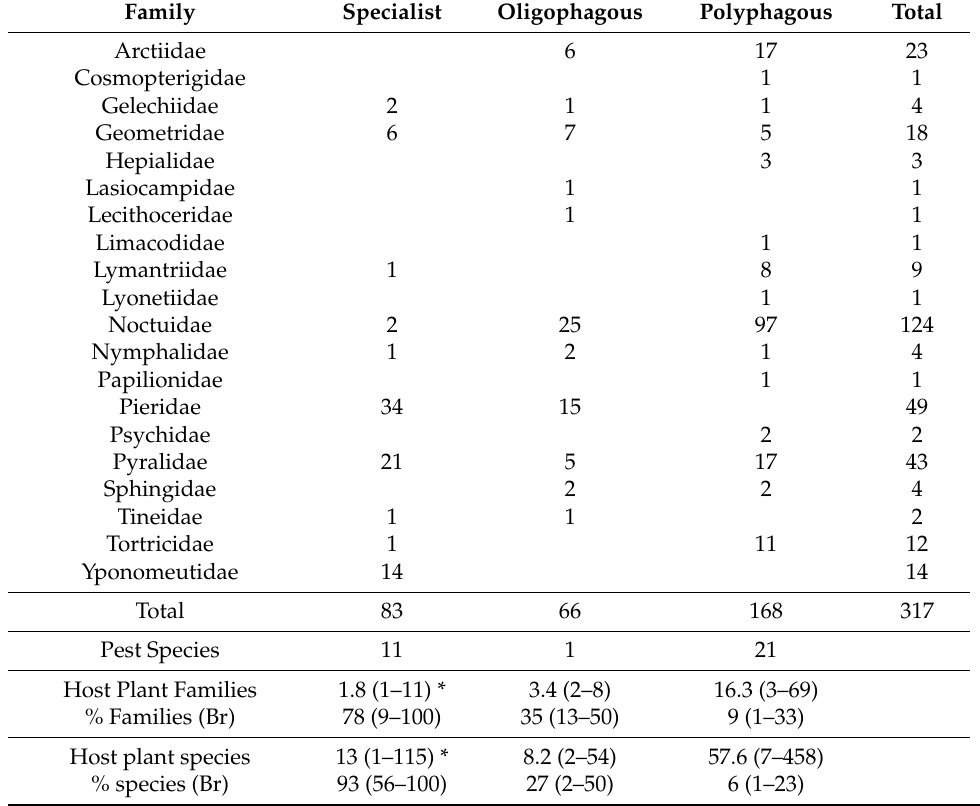
Table 1. Brassicaceae (Cruciferae) host plant use recorded by lepidopteran families with insect species classified as specialist, oligophagous or polyphagous. The number of pest species, mean number of host plant families (range is min and max), mean % families that are Brassicaceae (Br), mean number of host plant species and mean % of host species that are Brassicaceae (Br). See Supplementary Table S1 for species